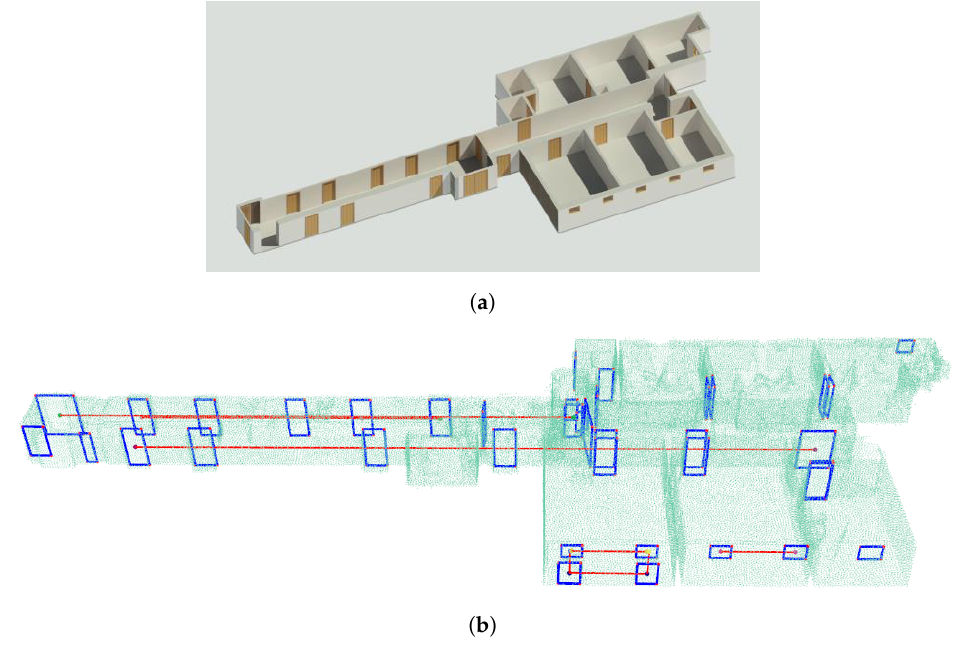
Figure 10. Opening detection and reconstruction on the point cloud of TUB1. ( a ) Benchmark model of TUB1 [40]; ( b ) Reconstructions (blue frames) and structural topology (red lines) of openings (doors and windows) on wall surfaces. For the sake of clear presentation, the TUB1 point cloud is subsampled with a minimum spacing of 0.1